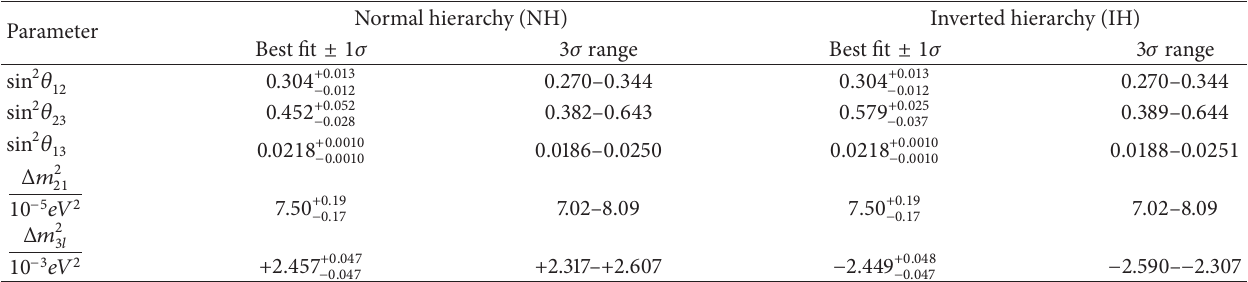
Table 3: Global analysis of solar, atmospheric, reactor, and accelerator neutrino data in the framework of three-neutrino oscillations. Here, ≡ Δ𝑚 2 Δ𝑚 2 ≡ Δ𝑚 2 Δ𝑚 2 3𝑙 31 for NH and 3𝑙 32 for